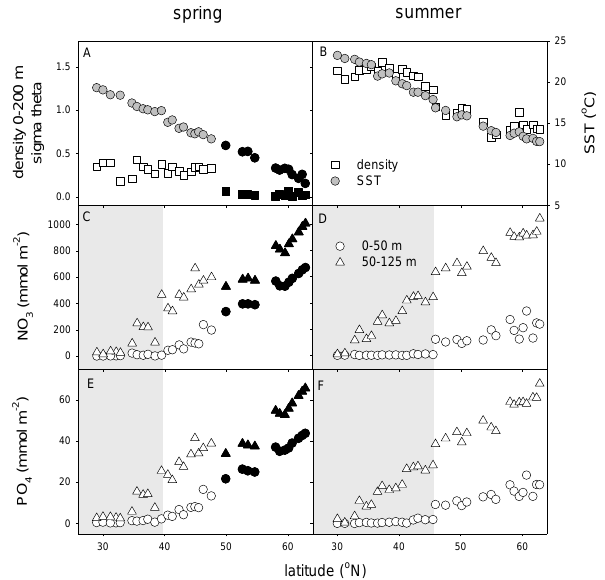
Fig. 2. Latitudinal changes in abiotic data from the spring (A, C, E) and summer (B, D, F) cruises. (A, B) Density differences in the upper 200m and sea surface temperature (SST, secondary y- axis). (C, D) Depth-integrated nitrate (NO 3 ) concentration in the upper (0–50m) and lower (50–125m) euphotic zone. (E, F) Depth- integrated inorganic phosphate (PO 4 ) concentration in the upper (0–50m) and lower (50–125m) euphotic zone. Black symbols rep- resent data from non-stratified stations. The gray area indicates re- gions with oligotrophic